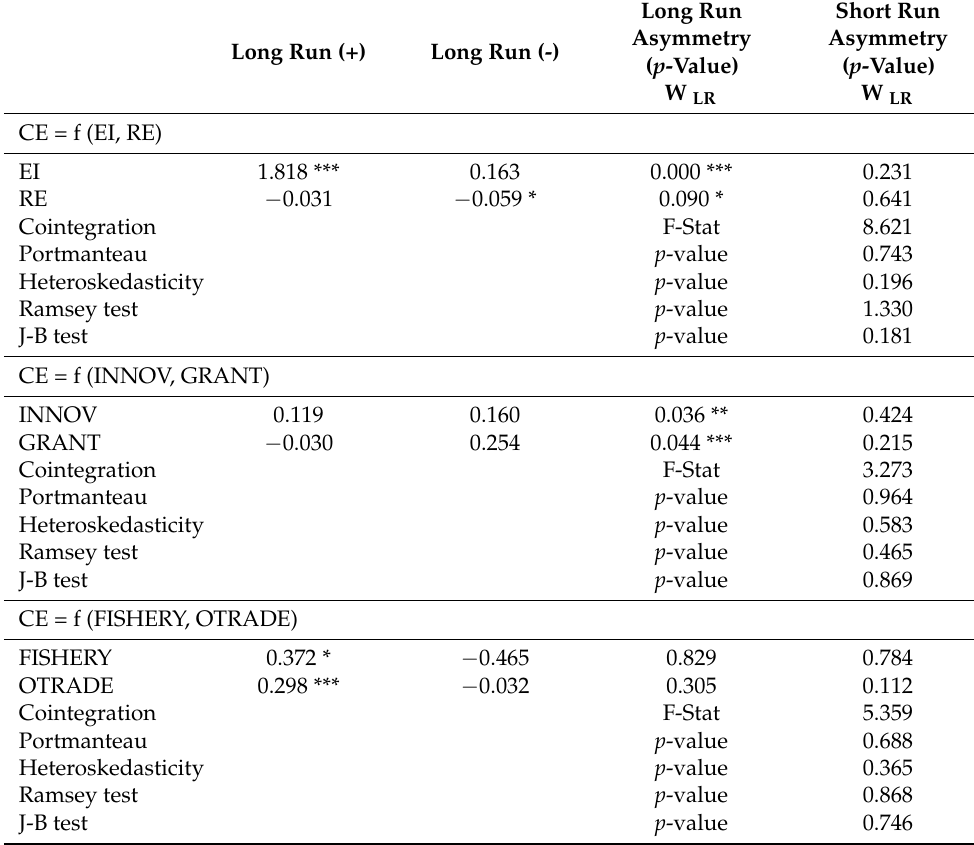
Table 10. Asymmetric and model diagnostics (before Vision 2030).